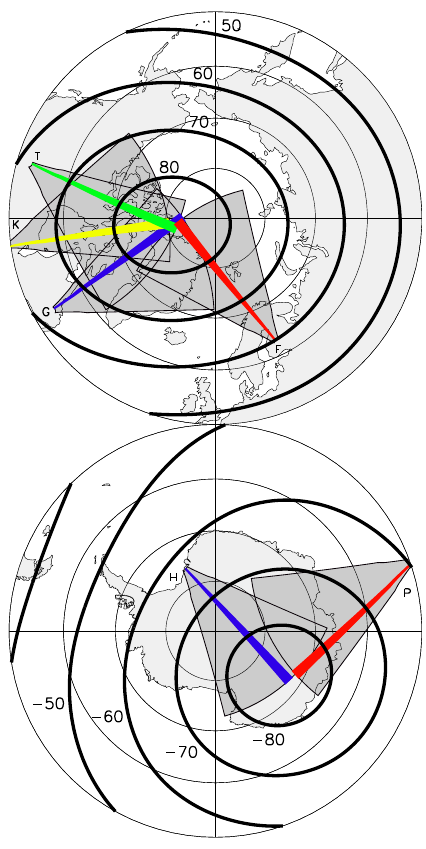
Fig. 1. Northern and Southern Hemisphere polar maps (geographic coordinates) showing the fields of view of the SuperDARN radars employed in this study. The Northern Hemisphere radars used are CUTLASS Finland (F), Goose Bay (G), Kapuskasing (K), and Saskatoon (T). The Southern Hemisphere radars used are Halley (H) and Kerguelen (P). The bold black lines represent contours of constant altitude-adjusted corrected geomagnetic (AACGM) lati- tude (latitudes as shown). The coloured beams represent the merid- ional beams for each radar as used in this